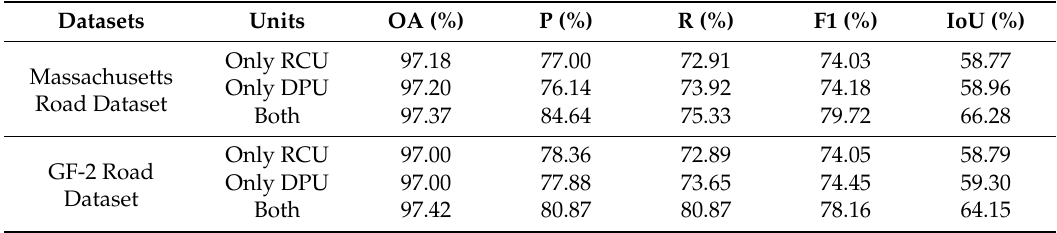
Table 9. Comparison of the results with either RCUs or DPUs at the breakeven